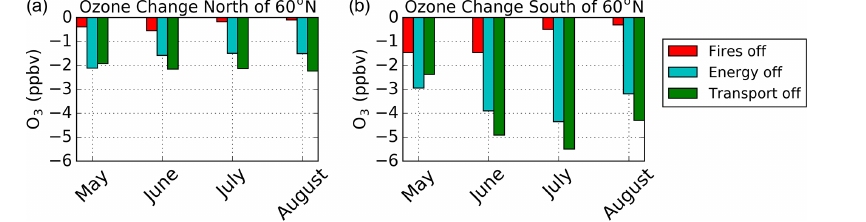
Figure 9. Surface ozone change relative to control simulation for the section of the domain north of 60 ◦ N (a) and south of 60 ◦ N (b) for the three sensitivity simulations, fires_off (red), ene_off (blue) and trans_off